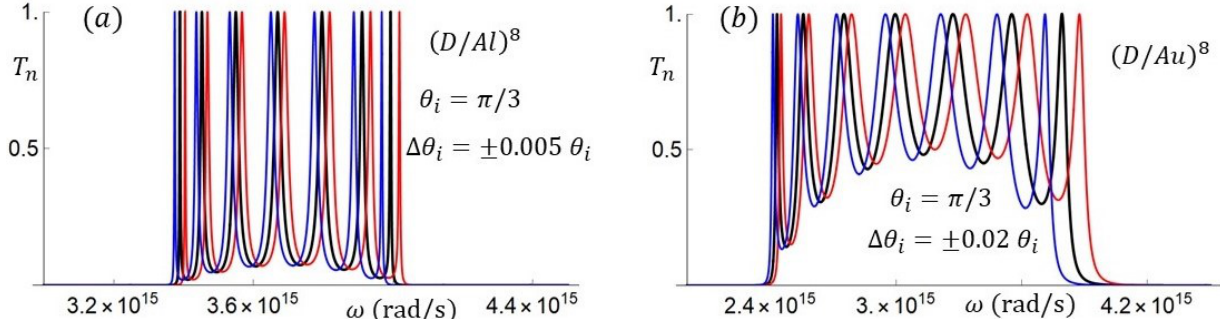
Figure 14. Sensitivity of the transmission resonances to incidence angle variations. In subfigures ( a , b ) θ i = π /3 (black curve), d c = 20 nm and d a = 400 nm. In subfigure ( a ) a ( dielectric / aluminum ) n superlattice with n = 8, and screened plasma frequency ω p = 10.6 eV. In this case, ∆ θ i = ± 0.005 θ i for the (red/blue) curves, respectively. In subfigure ( b ), a ( dielectric / gold ) n superlattice with n = 8, and screened plasma frequency ω p = 3.77 eV. In this case, ∆ θ (red/blue) curves,